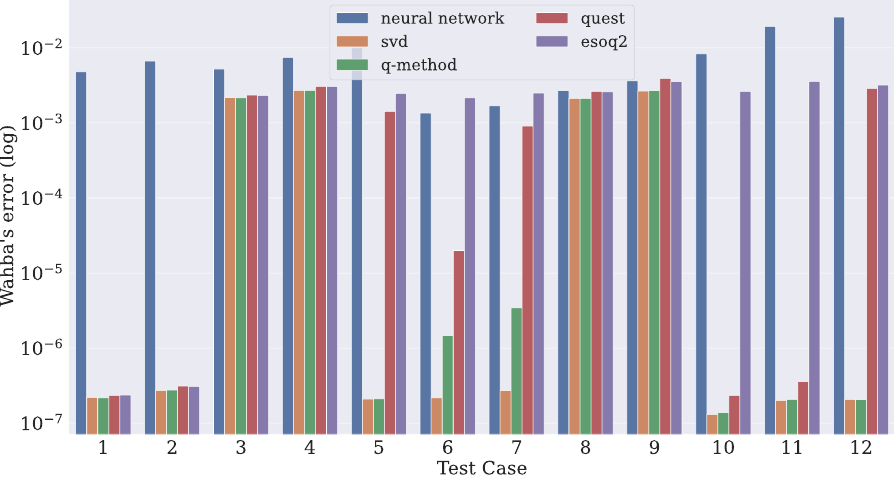
Figure 12. Comparison of the evaluation of Wahba’s error among some algorithms.